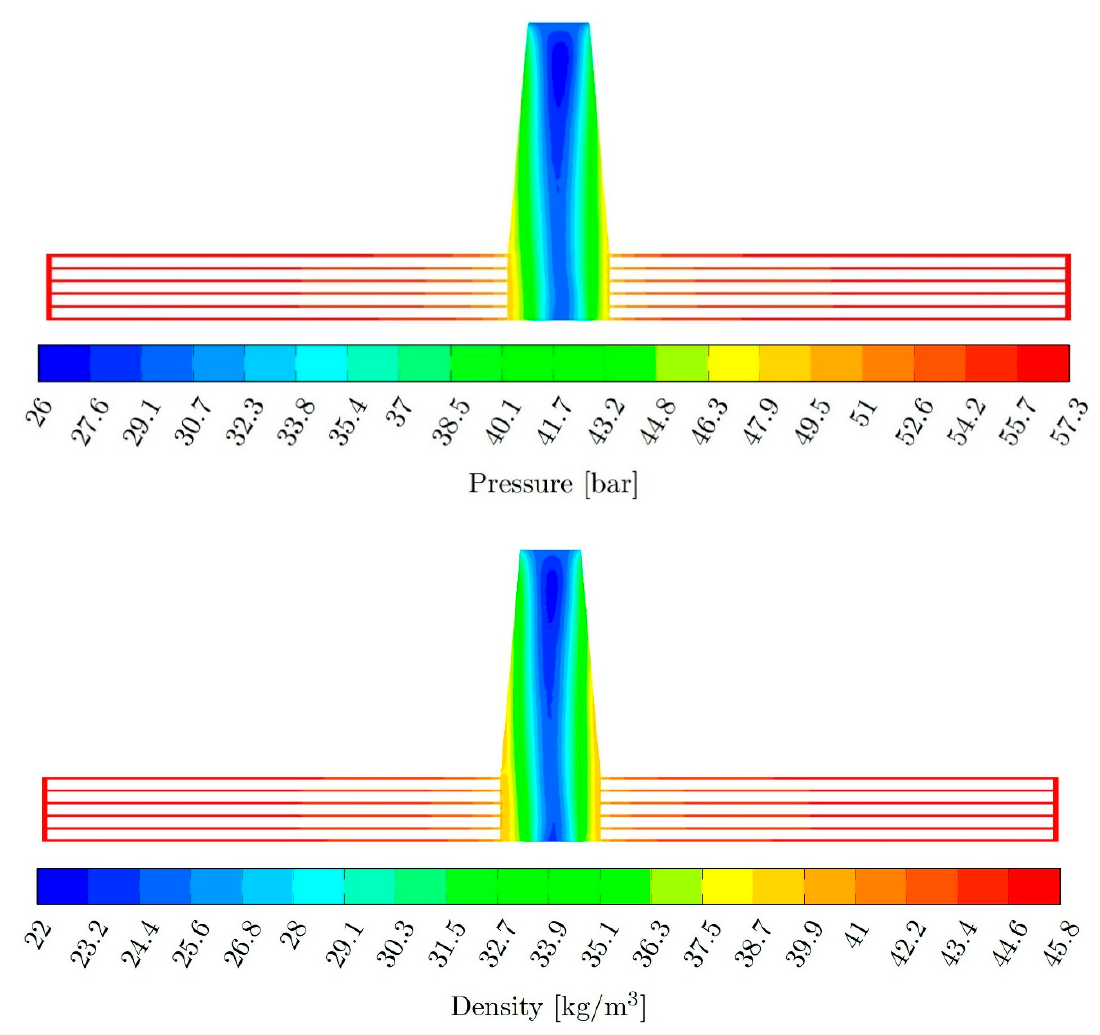
Figure 9. Distribution of pressure ( up ) and density ( down ) contours inside a TT.